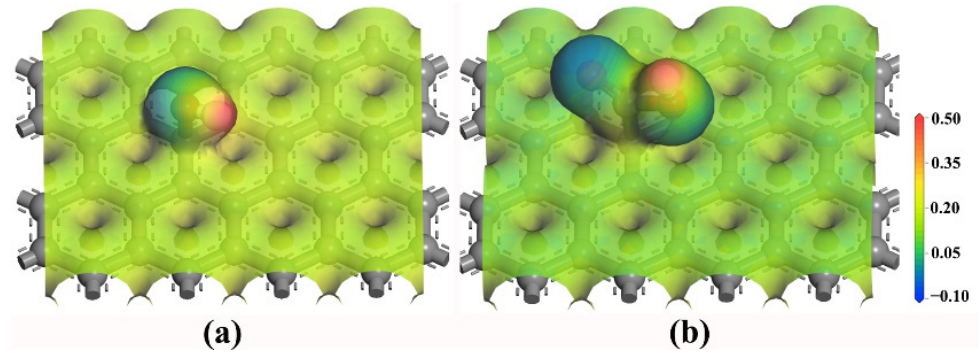
Figure 14. Electrostatic potential diagram of two functional groups ( a ) Hydroxyl group; ( b ) Carbo- xyl